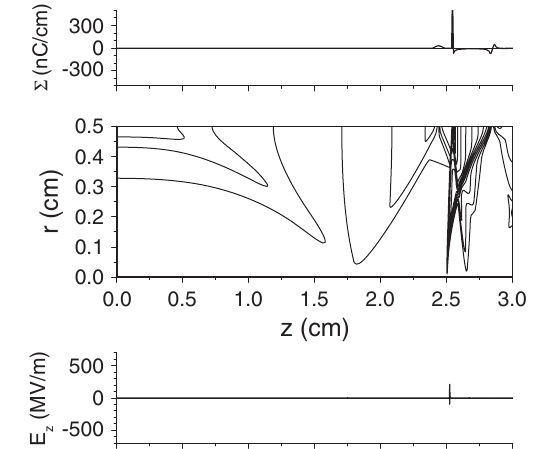
FIG. 12. Flux lines, axial electric field on the beam axis, and the lineal surface charge density, just after a beam bunch passed through the exit boundary of a cavity in Figs. 10 and 11.